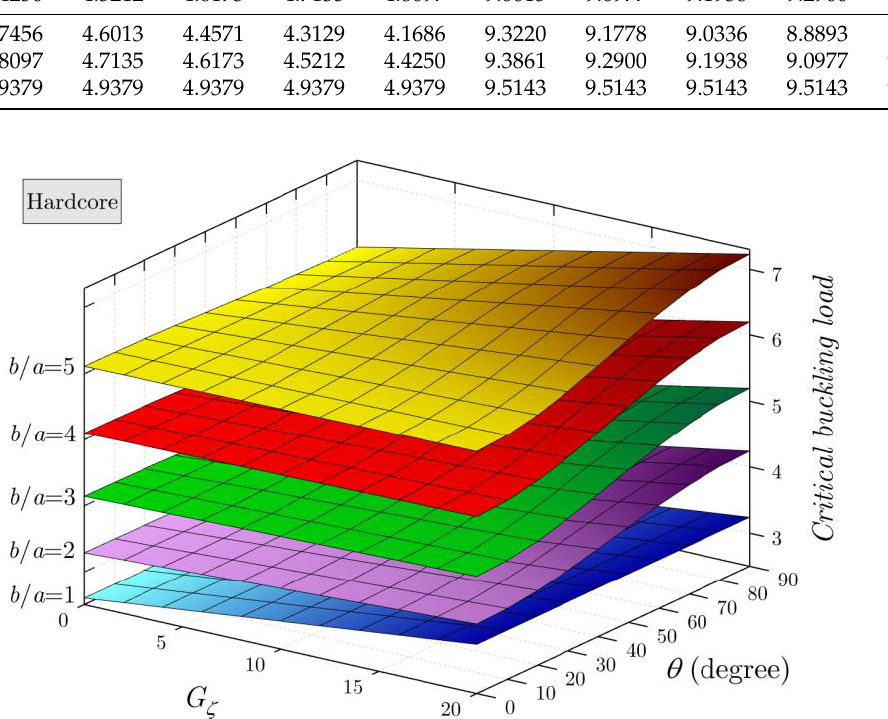
Figure 12. Effect of the orthotropic elastic foundation on the dimensionless critical buckling load 𝑁̅ of coated FG shells (𝑆𝑆𝑆𝑆, 𝑅 = 5, 𝑝 = 𝑘 = 𝑒 = 2, 𝑏 = 𝑎/2 = 5ℎ, 𝜇 = 𝜆 = 0, 𝐺 𝜂 = 2) . For further analysis, Figure 13 was plotted to view the action of the aspect ratio on the intensity of the orthotropy direction “ 𝜃 ” and therefore the critical buckling loads. The orthotropy direction “ 𝜃 ” was changed from 0° to 90°. It can be seen that the orthotropy direction had no influence on the buckling response in the case of shells with equal edges ( b / a= 1); therefore, the increase in the ratio b / a supported the effect of the orthotropy direc- tion on the buckling loads, which were augmented by the augmentation of the orthotropy direction “ 𝜃 ”.